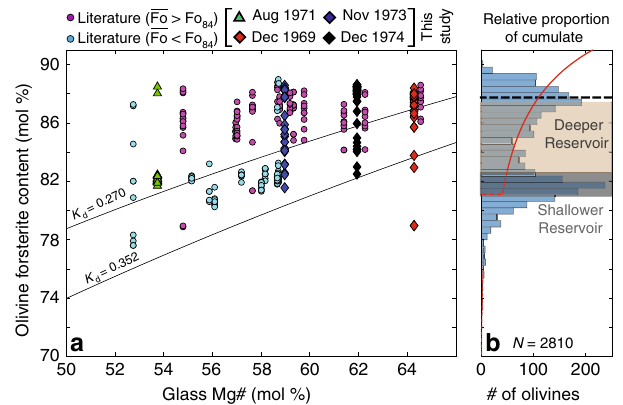
Fig. 3 Primitive crystal cargoes consist largely of antecrysts. a Olivine forsterite contents versus matrix glass Mg# (Fe 3 + /Fe T = 0.15; ref. 65 ). Olivine-liquid equilibrium lines are shown for K D = 0.270 – 0.352 (refs. 30,37 ). Eruptions with evolved crystal cargoes (mean forsterite content <Fo 84 ; cyan circles and green triangles) contain olivines lying closer to olivine-liquid equilibrium lines than eruptions with primitive crystal cargoes (mean forsterite content >Fo 84 ; magenta circles, blue, black and red diamonds). b Compilation of 2810 K ī lauean olivine core compositions (this study and literature; see Methods). The red line shows the expected distribution of forsterite contents following fractional crystallisation within a single reservoir from a primary melt composition (17.1 wt% MgO; ref. 29 ; see Methods). The solid section of the line represents the composition of olivines that would crystallise from primary melts, down to the composition of the most evolved melts present within the SC reservoir. The dashed section of the line represents the olivine compositions that would crystallise from more evolved melts. The beige box shows the range of olivine compositions that would crystallise from the observed distribution of glass compositions in eruptions thought to originate in the SC reservoir (~10 ± 2 wt% MgO), while the grey box shows the olivine compositions that would crystallise from the observed distribution of glass compositions in eruptions thought to originate in the shallower, HMM reservoir (~7 ± 1 wt% MgO; ref. 27 ). The black dashed line shows the mean olivine composition produced by the fractionation trajectory indicated by the solid red line (17.1 wt% MgO to 8 wt% MgO). Models run in Petrolog3 at QFM, K D = 0.3 (see